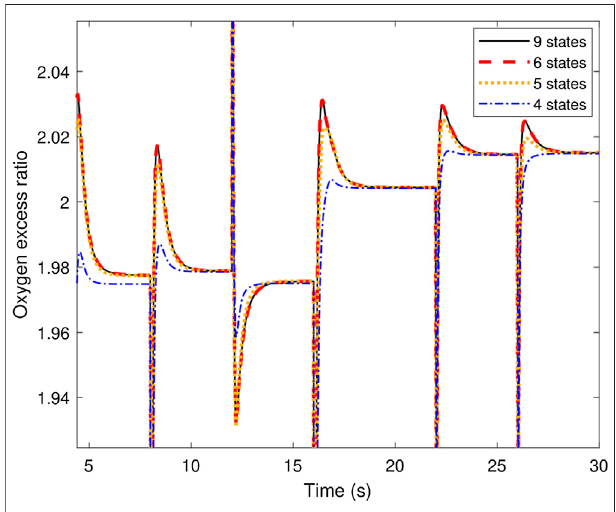
FIGURE 2 | The OER response for models of different